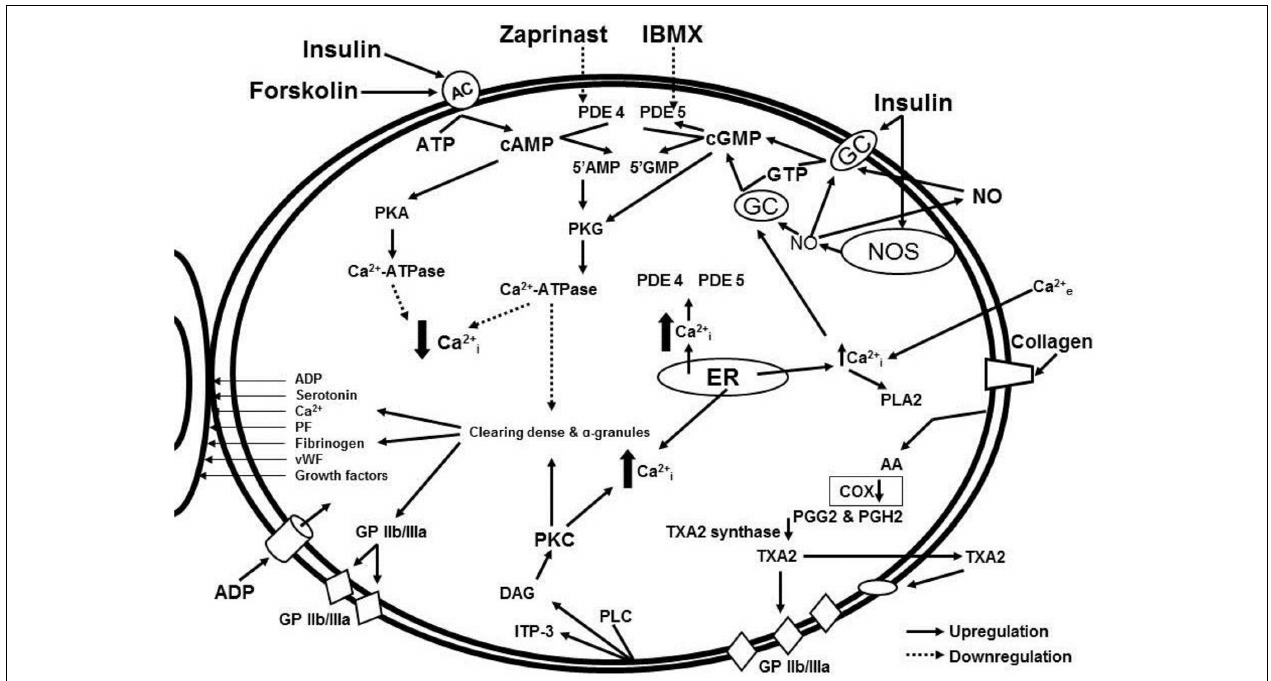
FIGURE 1 | Signaling pathway interaction and effects of modulators: cGMP and cAMP-dependent intracellular signaling systems in the insulin-mediated regulation of platelet aggregation in patients with metabolic disorders.